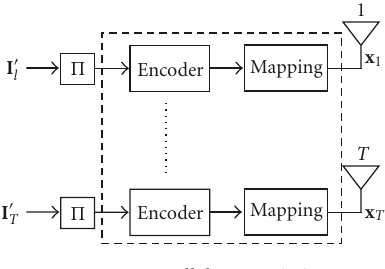
Figure 3: Parallel